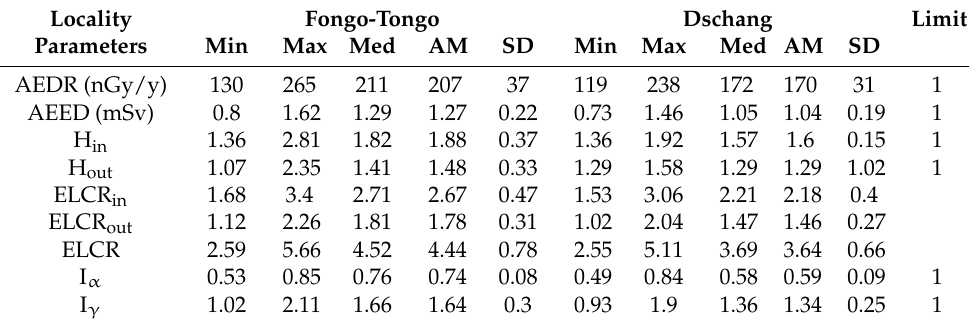
Table 4. Summary of the different radiological parameters obtained in laboratory.